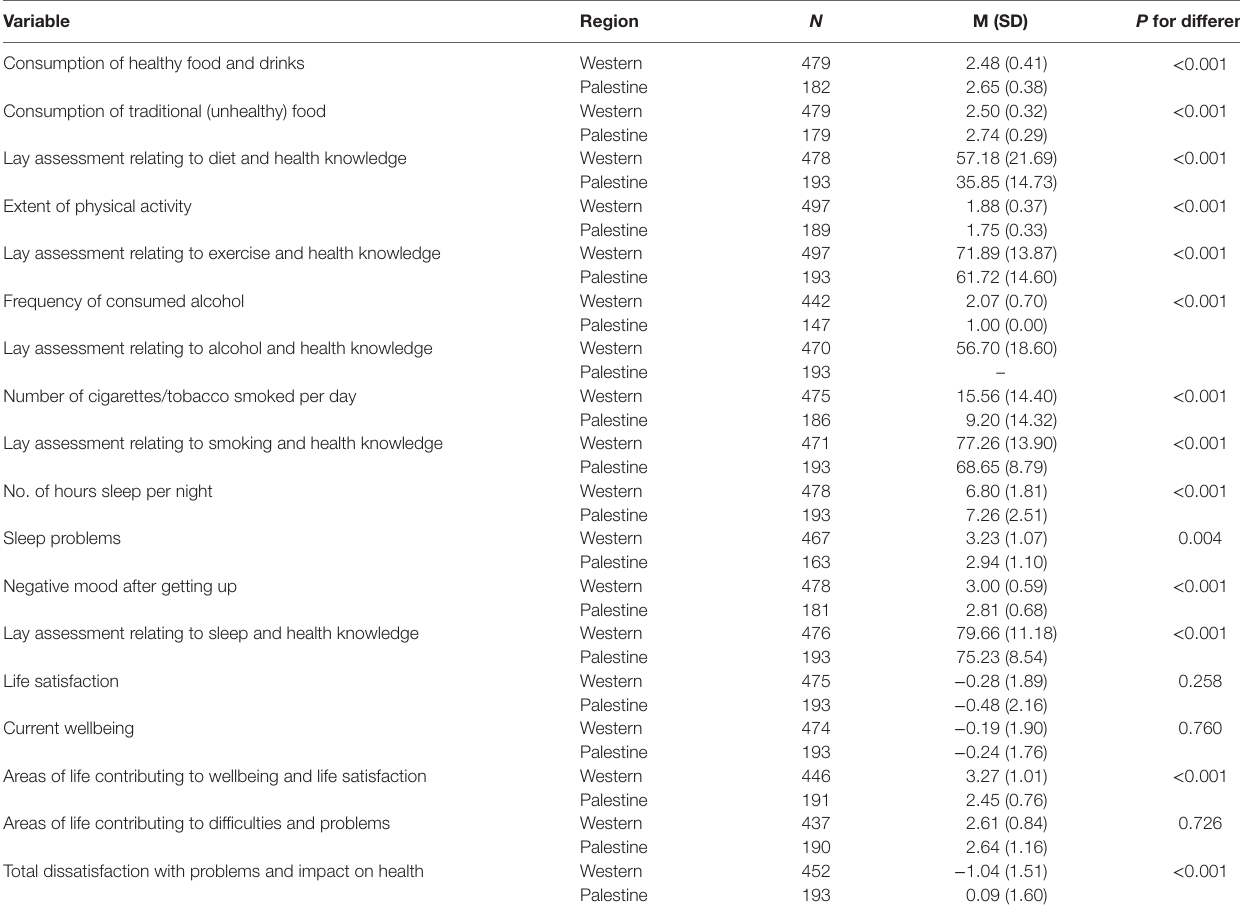
TaBle 2 | comparison of Western and Palestinian samples. Variable region P for difference Consumption of healthy food and